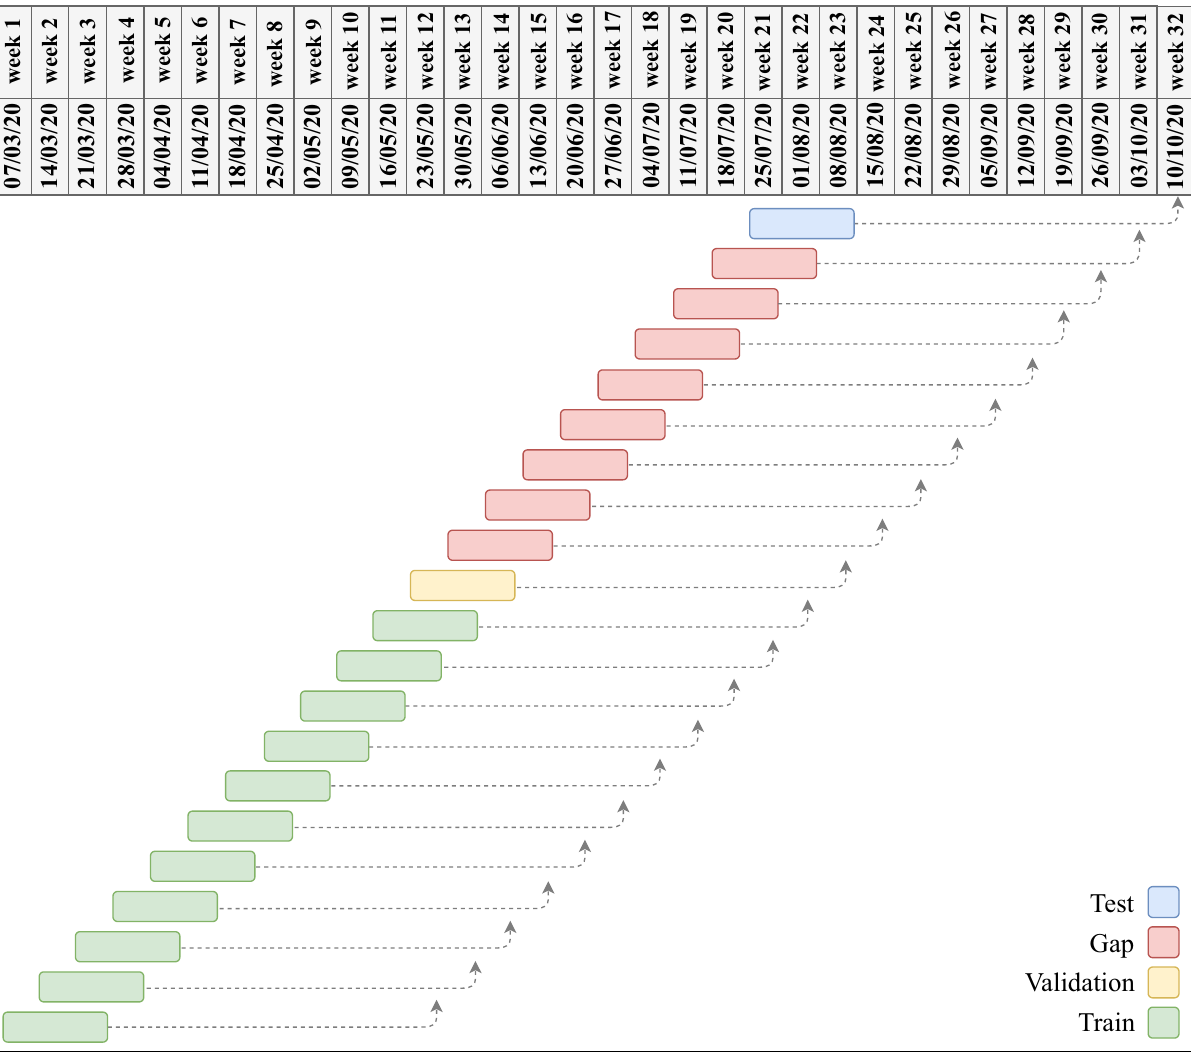
Figure 7. Partitioning the dataset into train, validation and test sets. The forecasting task is to use the covariates at weeks t , t -1, t -2 to forecast the target variable at week t + 9. So the forecast horizon is nine ( r = 9) and the history length is three ( h = 3). Each row in the graph corresponds to an instance. The length of the dashed arrows are the forecast horizon and the length of the rectangles are the history length. The last instance is taken as the test dataset; that is, to forecast week October 3–10 using the covariates on weeks July 25 to August 8. The earlier eight red instances are not used and the yellow one before is used as the validation data instance. The green instances form the training